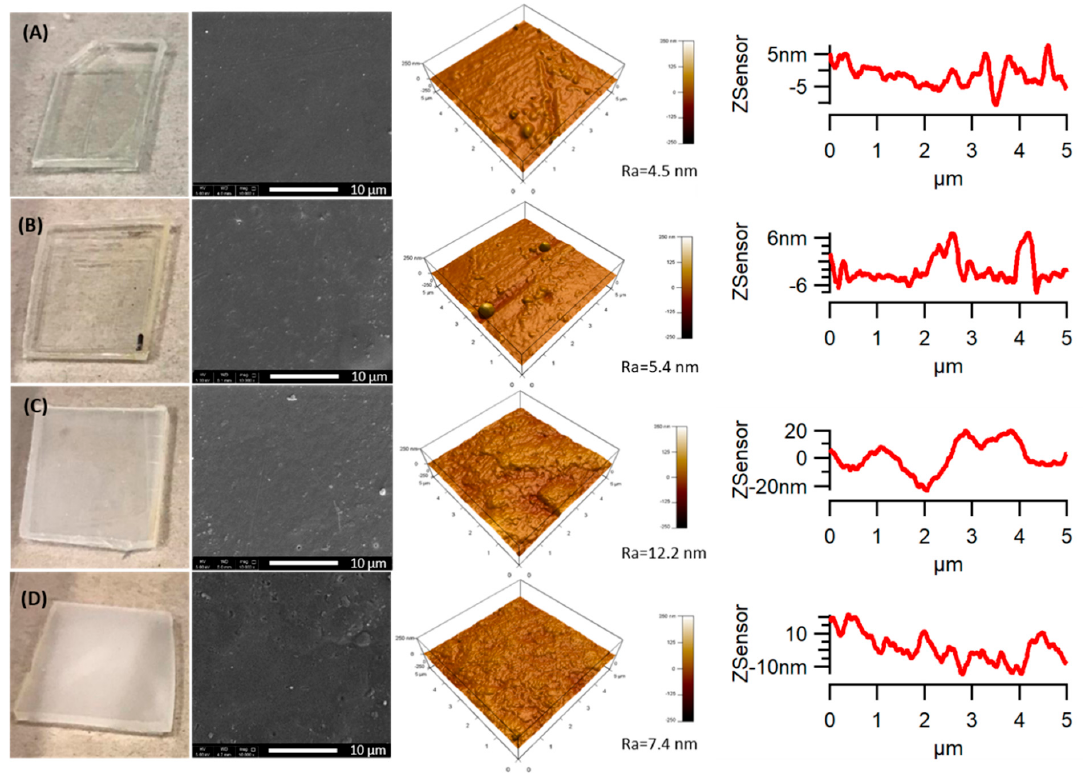
Figure 1. Scanning electron microscopy (SEM) and atomic force microscopy (AFM) images (3D height and line profile) of poly(lactic acid) (PLA) samples before and after accelerated weathering: ( A ) 0 h; ( B ) 500 h; ( C ) 1000 h and ( D ) 2000 h. Note: Ra represents the roughness parameter.